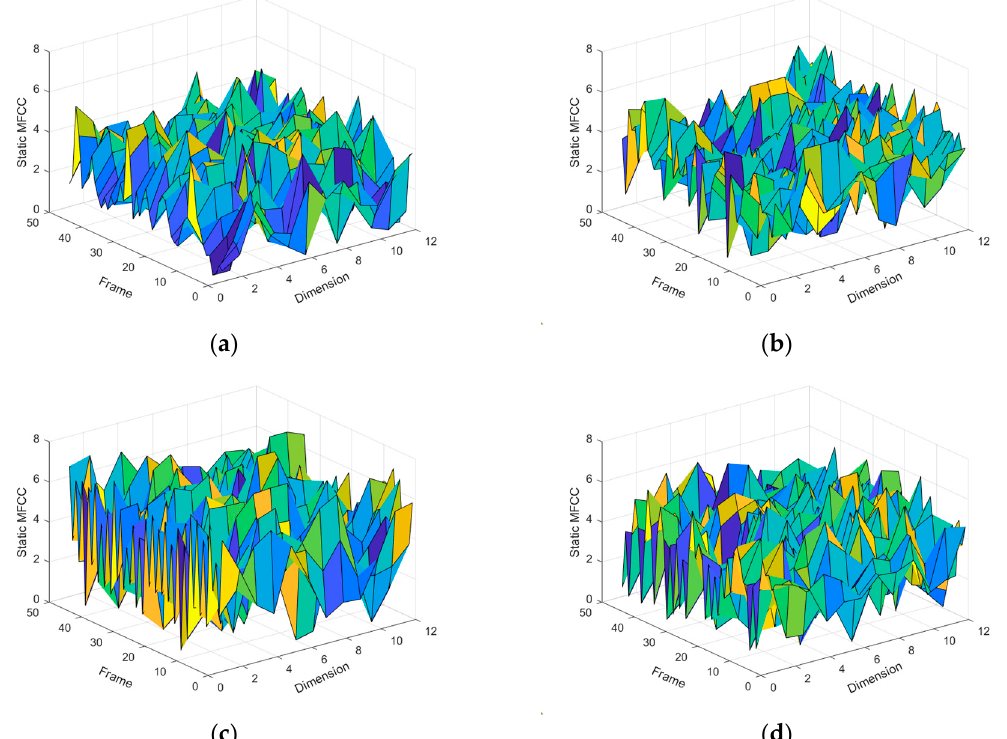
Figure 7. Static mel frequency cepstral coefficient (MFCC) features extracted from ultrasonic PD signals of GIS under different kind of insulation defects. ( a ) Free metal particles; ( b ) Floating electrode; ( c ) Creeping discharge; ( d ) Metal protrusions.